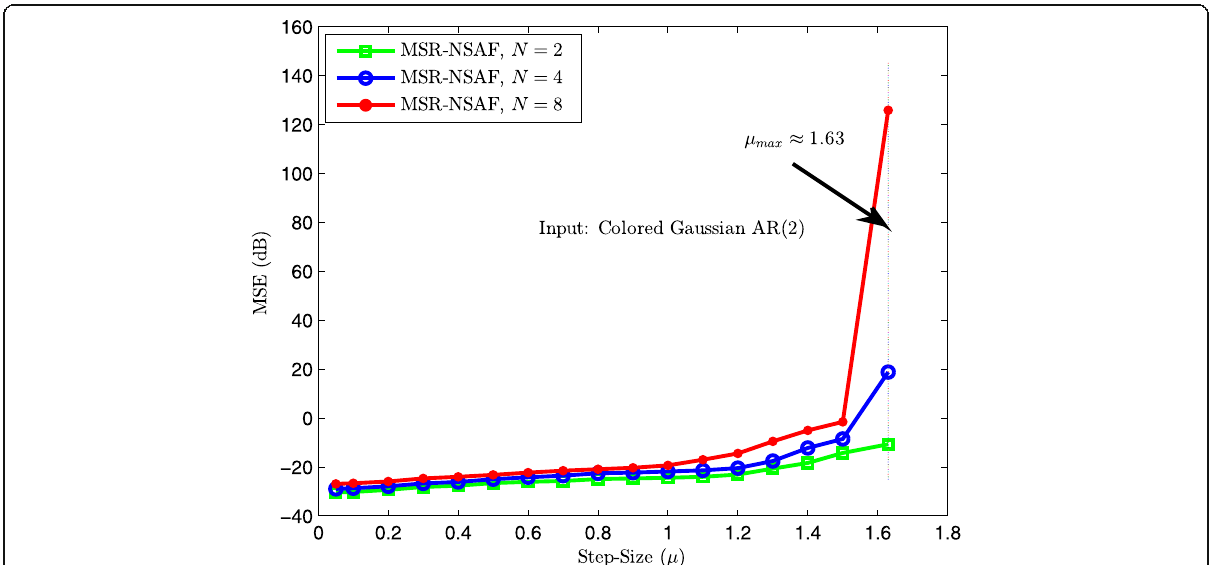
Fig. 25 Simulated steady-state MSE of MSR-NSAF with N = 2, 4, and 8 as a function of the